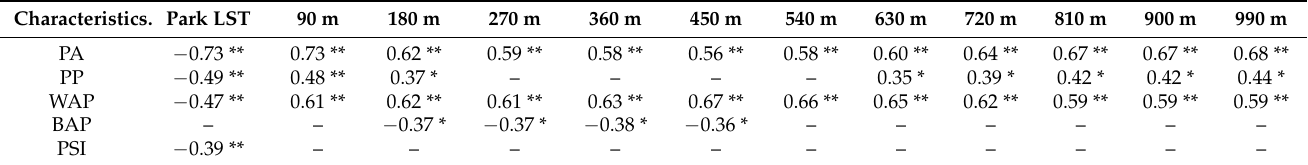
Table 4. The correlation coefficients for urban park features and LST.